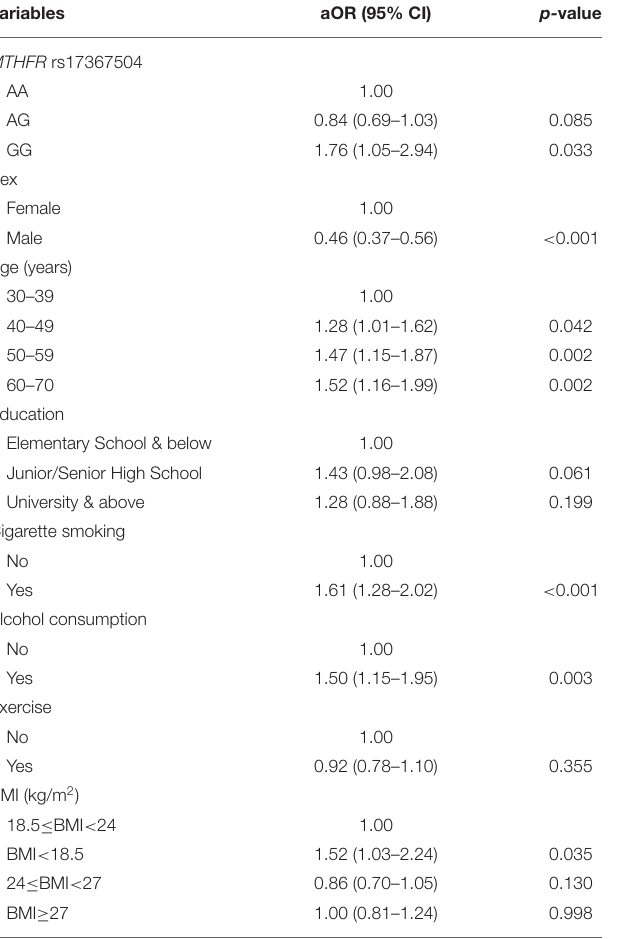
TABLE 3 | Association of MDD with MTHFR rs17367504 genotypes and sociodemographic and lifestyle factors stratified by exercise habits.